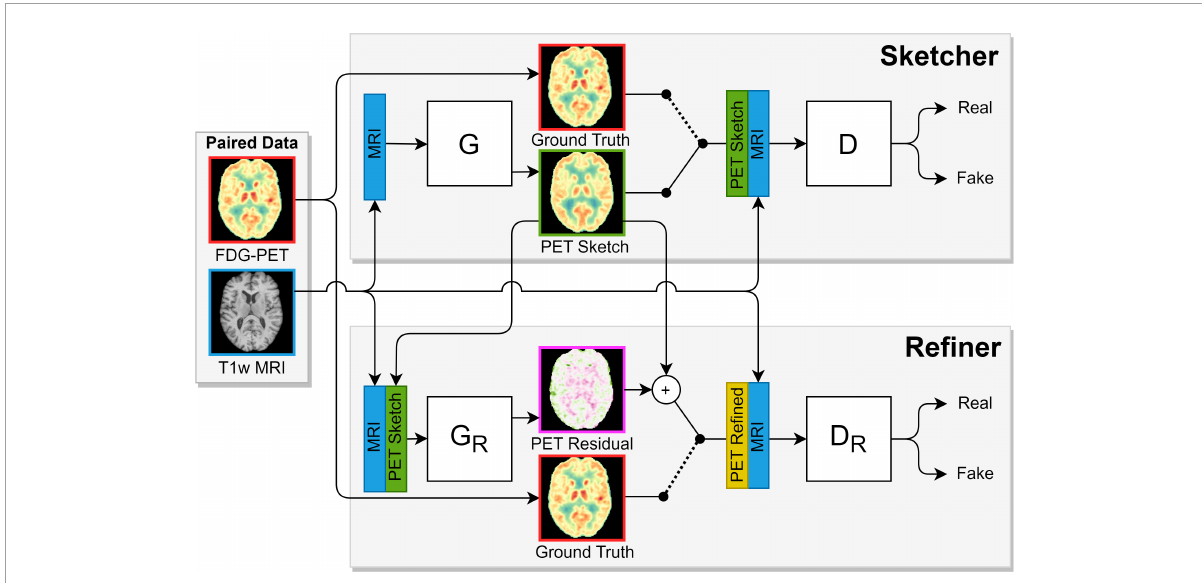
FIGURE2 The adversarial sketcher-refiner framework inspired by Gousias et al. (2008), Jenkinson et al. (2012). The sketcher generator (G) predicts a [ 18 F]FDG 3D patch (PET Sketch) from an MR 3D patch, and the refiner generator (G R ) enhances this to a final synthetic image patch (PET Refined). During training, the sketcher discriminator (D) is shown patches from MR, PET Sketch, and real PET (Ground truth) images. Likewise, the refiner discriminator is shown patches from MR, PET Refined, and real PET images. The discriminators try to distinguish real from synthetic images, which motivates the generators to synthesize compelling PET